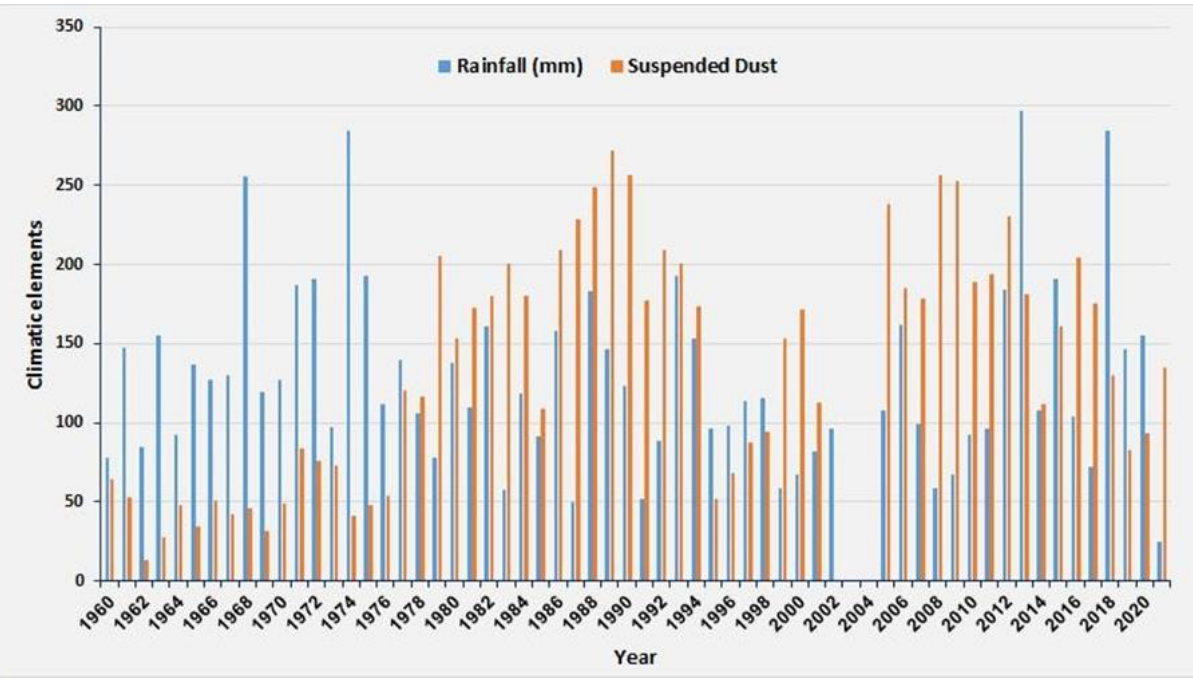
Figure 7. Bar shape shows the increase in the frequency of DSs with a decrease in rainfall over the past 61 years (1960 – 2021).